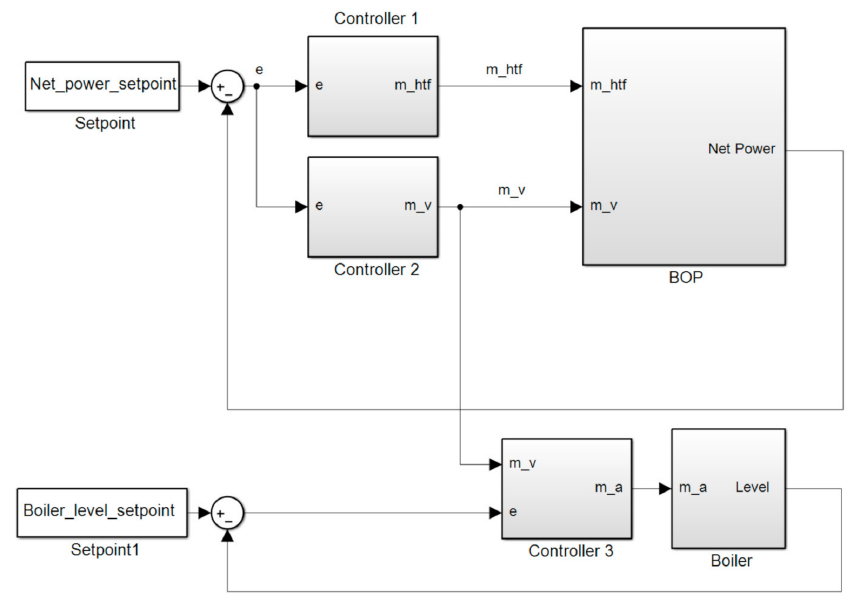
Figure 8. Sketch of the BOP control